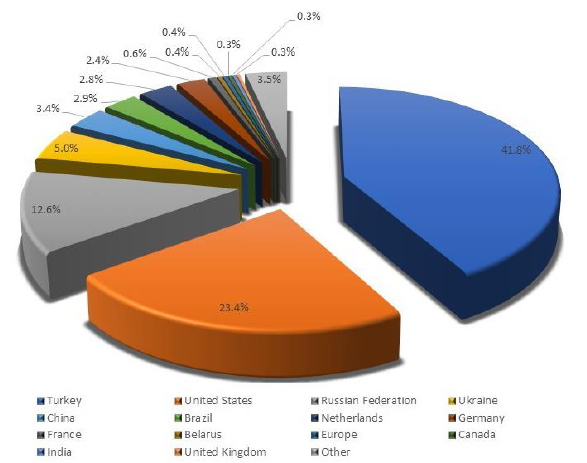
Figure 3. Country distribution of IP addresses